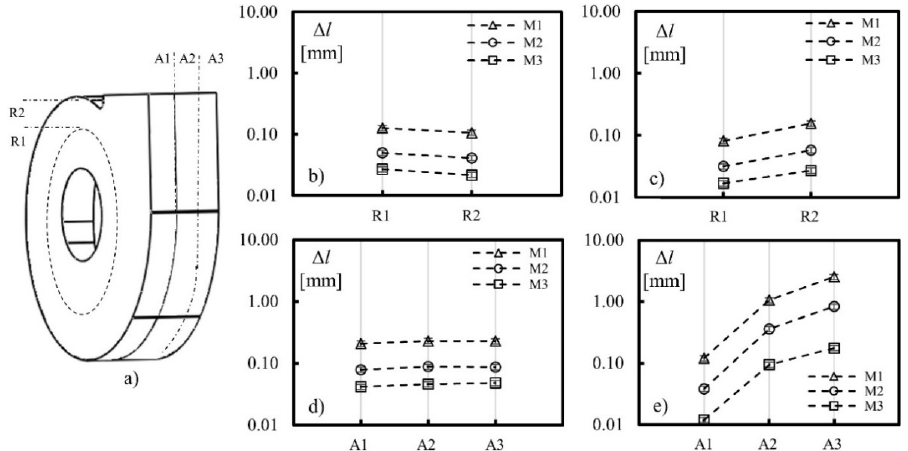
Figure 7. Volute wear: ( a ) coordinates of the patches on volute and material loss, ( b ) on the front side, ( c ) back side, ( d ) lateral side, and ( e ) cut-off. R3 and R4 are the radial annular areas, A1, A2 and A3 are the axial areas.